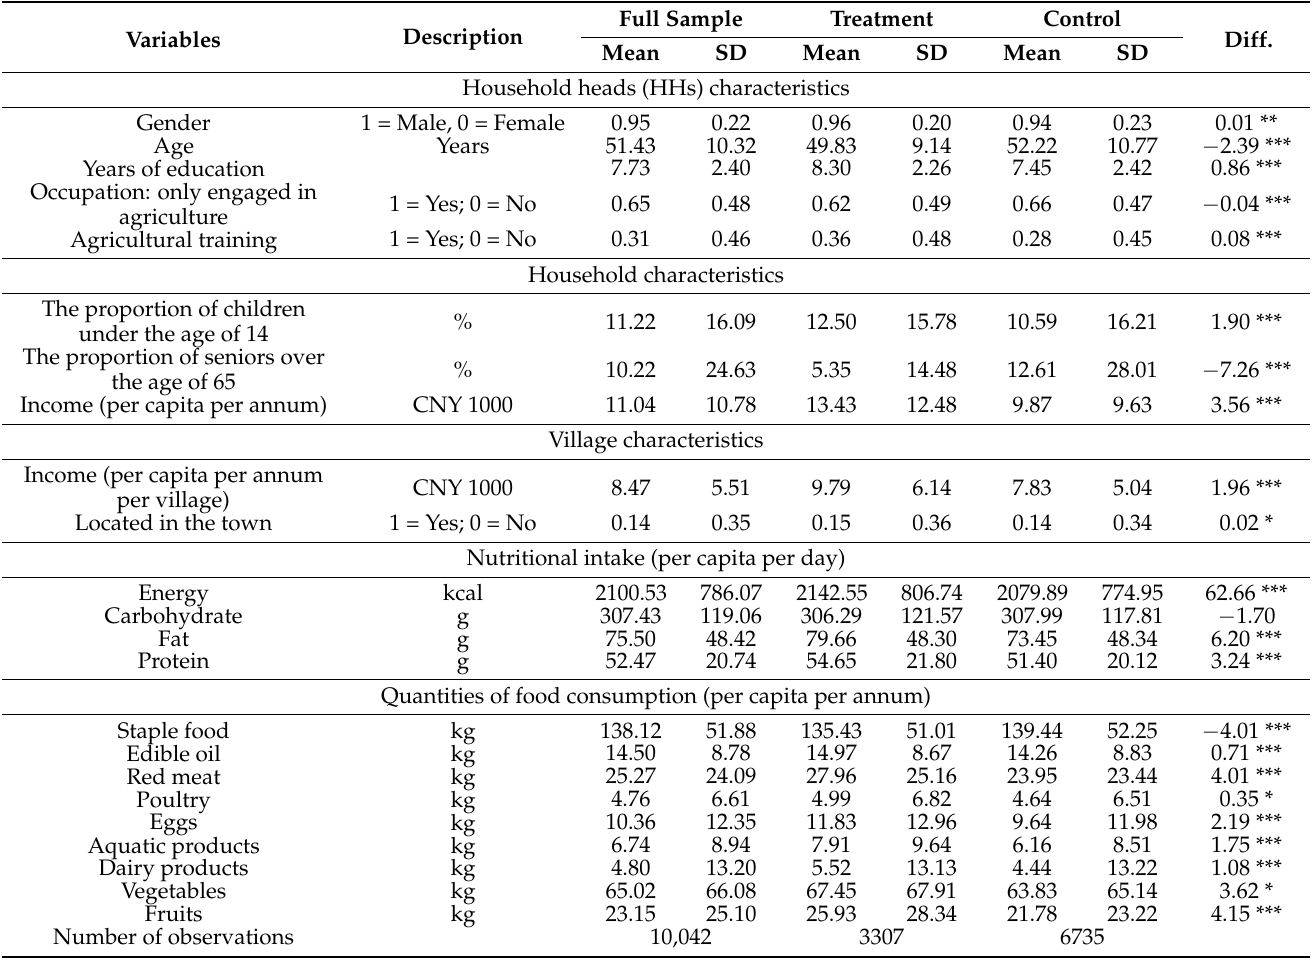
Table 1. Summary statistics of basic